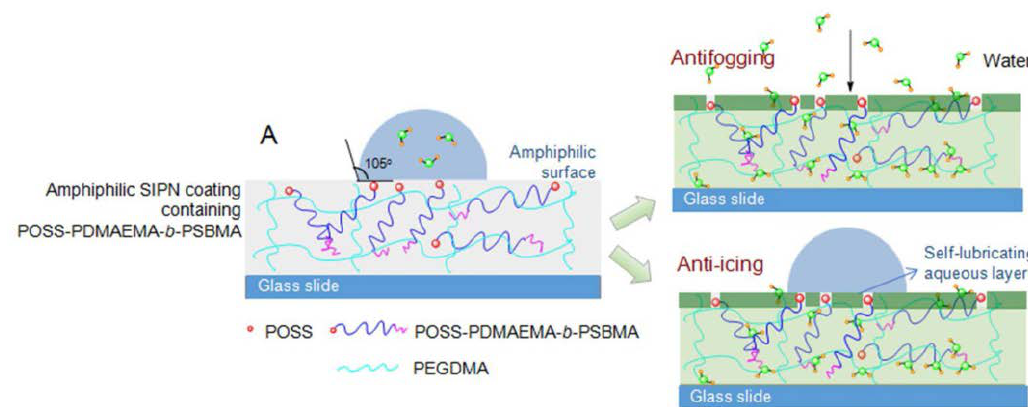
Figure 16. Schematic illustration of the semi-interpenetrating polymer network (SIPN) coatings containing POSS–PDMAEMA- b -PSBMA with POSS aggregated on the surface and the strongly hydrophilic chains distributed beneath them. Reprinted with permission from [132]. Copyright (2017) American Chemical Society.